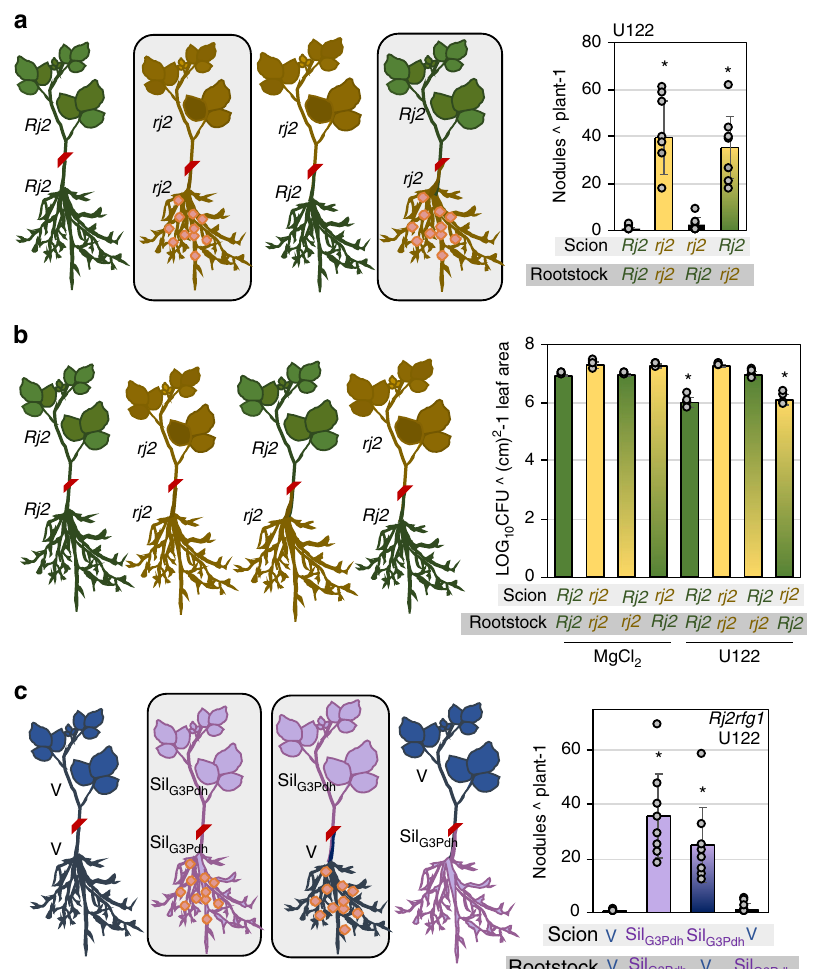
Fig. 6 Leaf-derived G3P is required for root exclusion of incompatible rhizobia. a Average number of nodules produced by U122 on grafts between Rj2 and rj2 genotypes. Genotype of rootstocks and scions are indicated in gray boxes below the x -axis. Boxed panels indicate grafts that produced nodules in response to U122. b Psg Vir counts on Rj2 and rj2 grafts pretreated (root) with buffer (MgCl 2 ) or U122. Psg Vir was inoculated on scions 48 h after pretreatment of rootstocks with U122. LOG 10 values of (CFU) colony forming units (cm) 2^-1 leaf area from infected leaves at 0 and 4 days post inoculation (dpi) are presented. Error bars indicate standard deviation ( n = 4). Asterisks denote signi fi cant difference between mock and U122 plants of corresponding genotypes, Student ’ s t -test, P < 0.005. c Average number of nodules produced by U122 on grafts between control VIGS vector inoculated (V) and G3Pdh knockdown (Sil G3Pdh ) Rj2 plants. Asterisks denote signi fi cant differences from V × V grafts, t -test, P <